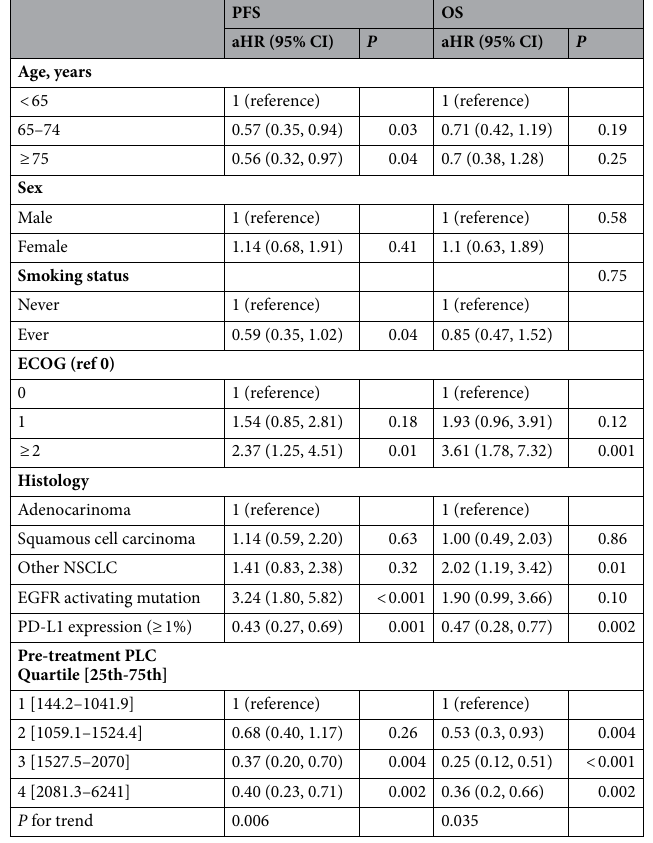
Table 2. Multivariate Cox proportional hazard regression analysis for progression-free survival (PFS) and overall survival (OS) according to pre-treatment peripheral lymphocyte count. PFS, progression-free survival; OS, overall survival; aHR, adjusted hazard ratio; CI, confidence interval; PLC, peripheral lymphocyte